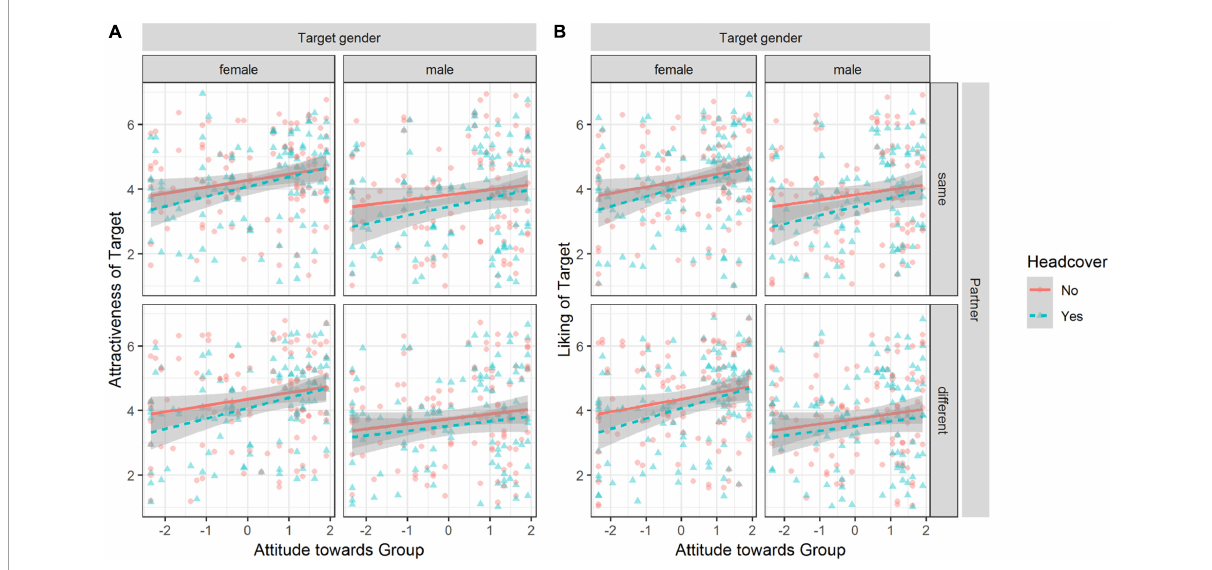
FIGURE7 Observed attractiveness and liking ratings dependent on attitude, headcover, target person gender, and partner. Plot (A) for perceived attractiveness, plot (B) for liking. Lines depict linear regression of Y on X and the shaded areas show the 95% CI of the estimate. Points are jittered to avoid